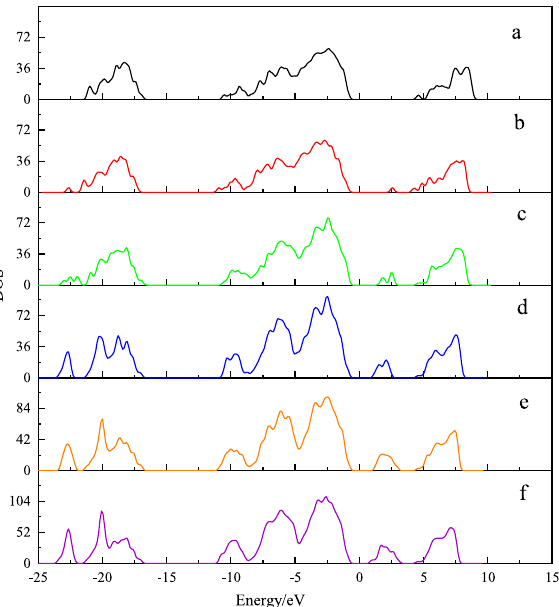
1 1 , 0.68 mmol g − ,